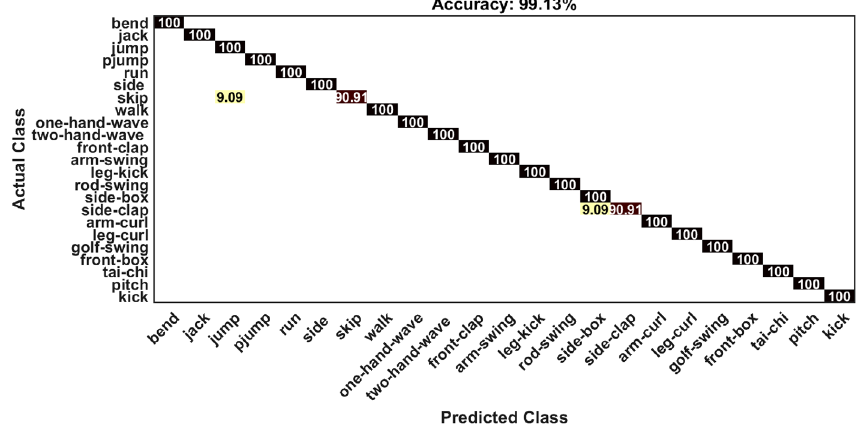
Fig. 10 Confusion matrix obtained for the DHA dataset